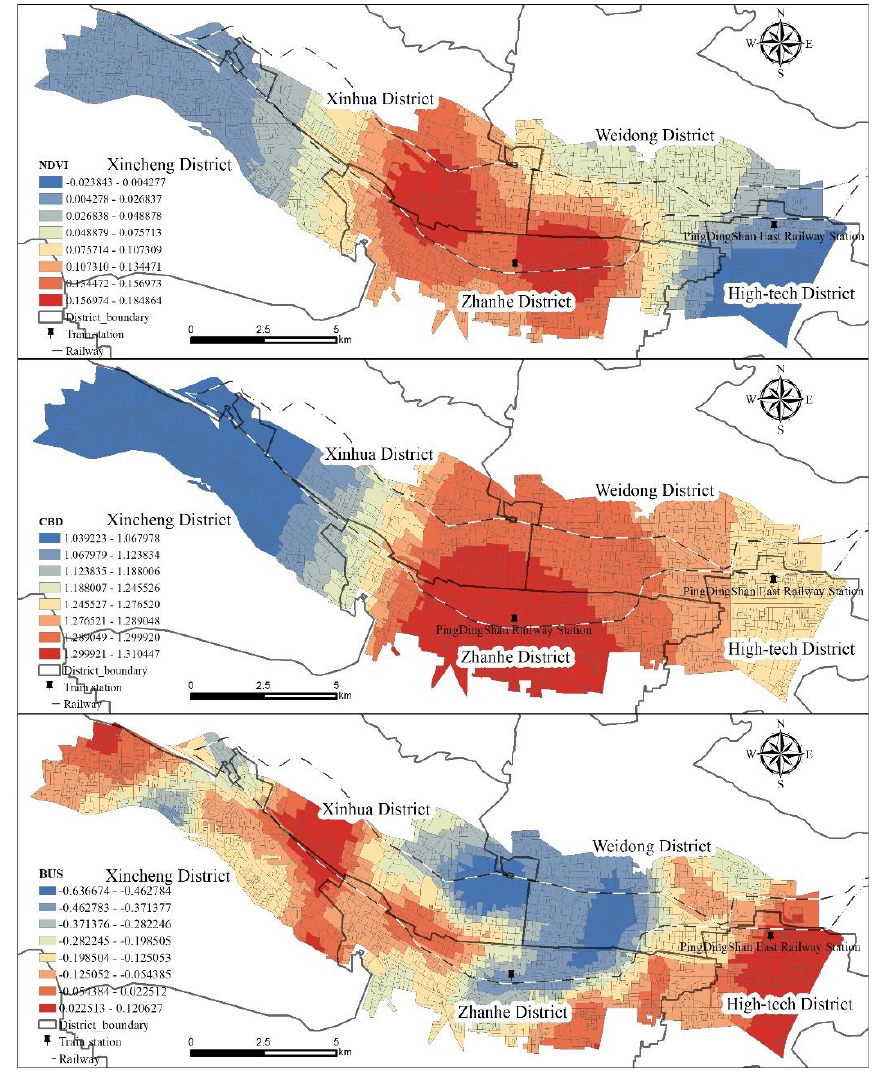
Figure 6. Spatial patterns of estimators of variables.